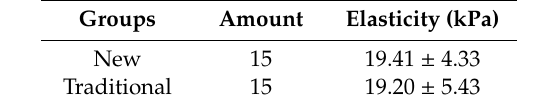
Table 1. Measuring results comparison between traditional and new method.